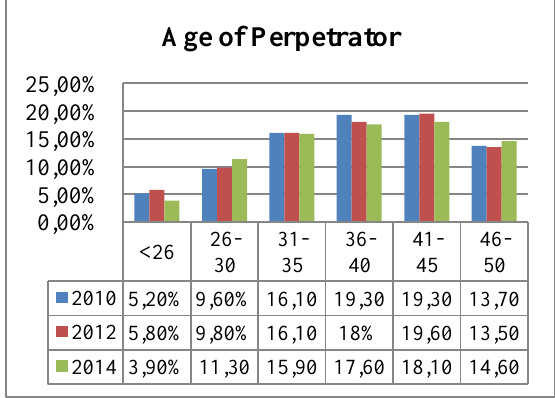
Figure 3. Age of Perpetrator